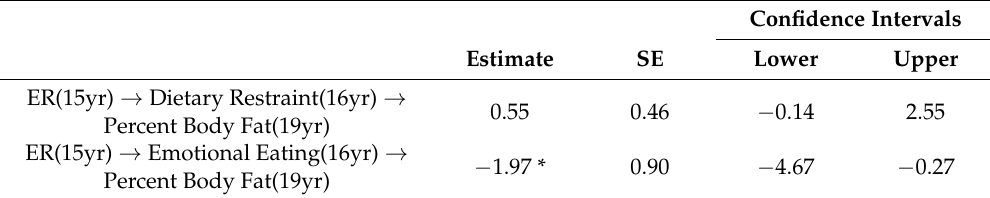
Table 2. Unstandardized Estimates of Indirect Effects, Standard Errors, and 95% Bias-Corrected Bootstrap Confidence Intervals.